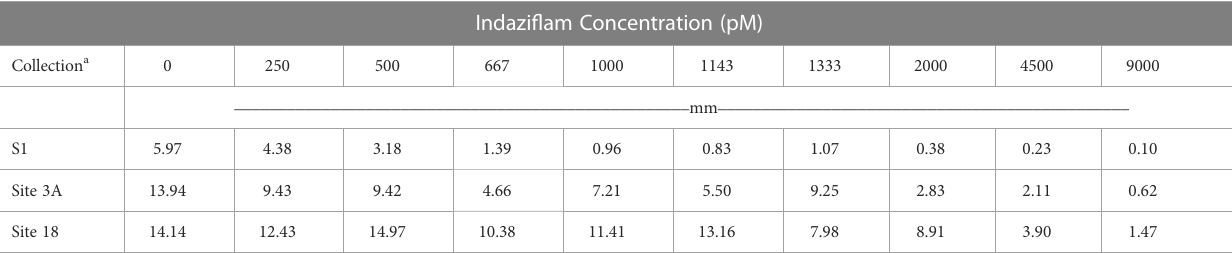
TABLE 2 Mean root length (mm) data for indazi fl am-resistant (Site 3A and Site 18) and -susceptible (S1) collections of P. annua in laboratory assays evaluating root growth in in Gelrite ® culture for 14